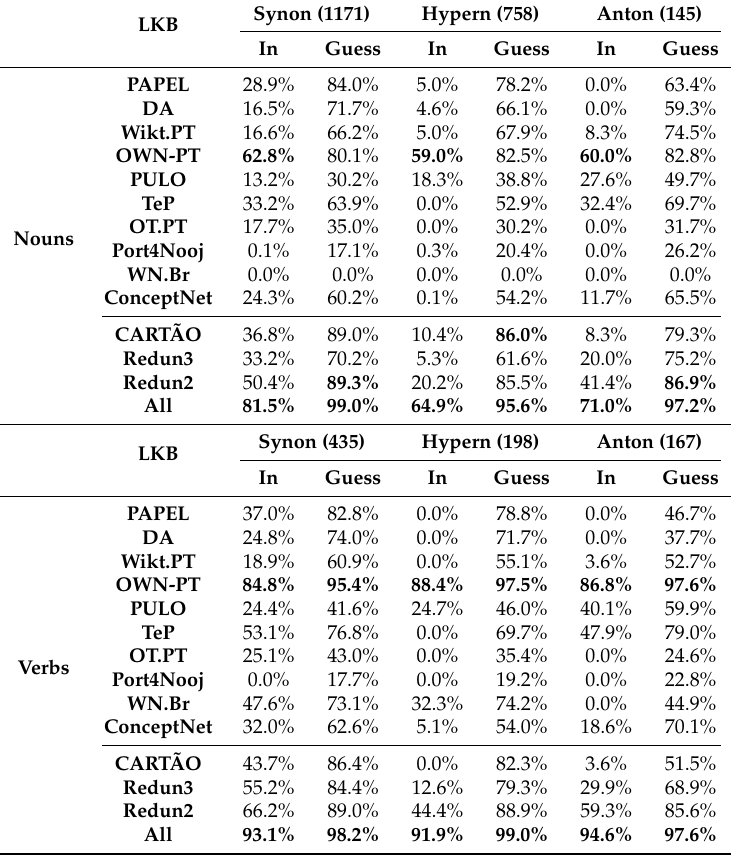
Table 11. Relation instances in and guessed from the B 2 SG test. Highest and second highest numbers are in bold. Synon (1171) Hypern (758) Anton (145) LKB In Guess In Guess In Guess